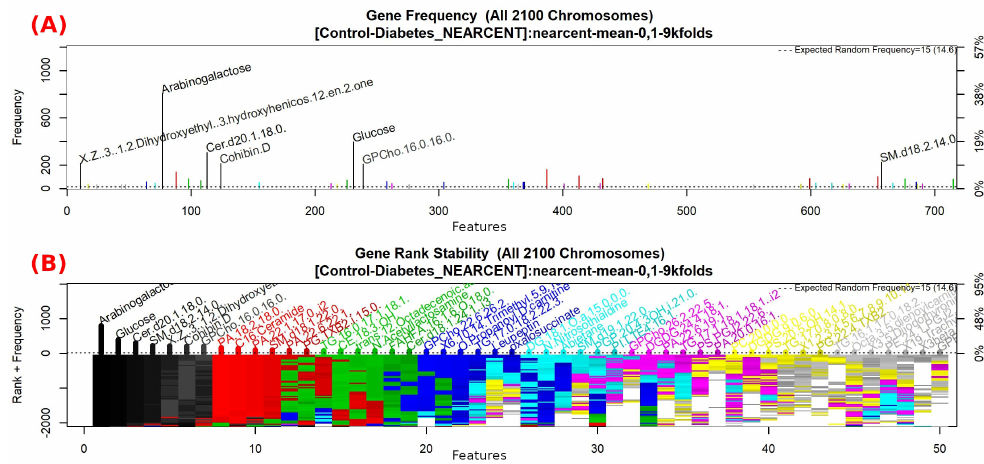
Figure 6. Gene frequency and gene rank stability in the models are ascertained by applying GA with NEARCENT to select the main features from the Control-T2DM dataset. ( A ) Gene frequency allows observing the number of times each feature appears in the models. ( B ) Gene rank allows observing the stability and frequency of each feature within the models and orders them by rank.